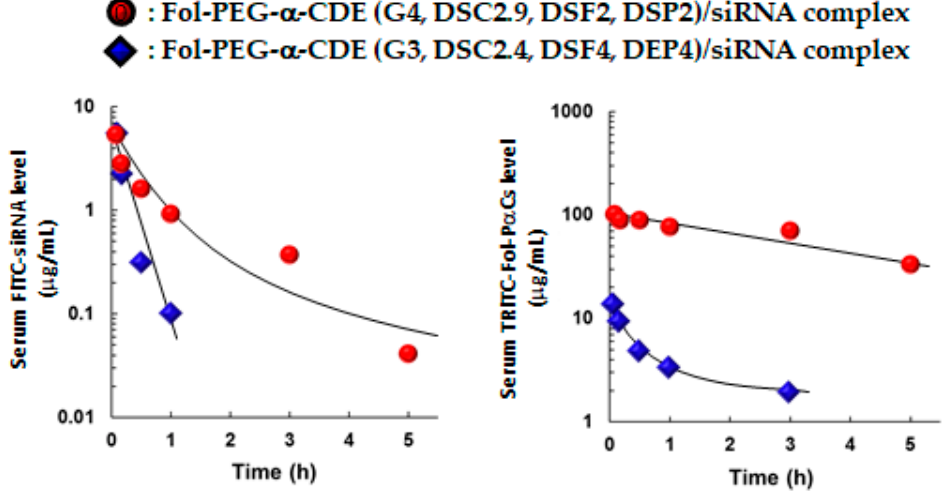
Figure 9. Time courses of blood levels of ( a ) FITC-siRNA and ( b ) TRITC-Fol-PEG- α -CDE (G4, DSC2.9, DSF2, DSP2) and TRITC-Fol-PEG- α -CDE (G3, DSC2.4, DSF4, DEP4) after intravenous injection of a solution containing TRITC-Fol-PEG- α - CDE (G4, DSC2.9, DSF2, DSP2)/FITC-siRNA complex and TRITC-Fol-PEG- α -CDE (G3, DSC2.4, DSF4, DEP4)/FITC-siRNA complex to tail vein of BALB/c mice bearing Colon-26 tumor cells. The charge (N/P) ratio of TRITC-Fol-PEG- α -CDE (G4, DSF2)/FITC-siRNA was 10. The amount of siRNA was 10 mg. Each point represents the mean±S.E. of 3–4 experiments.